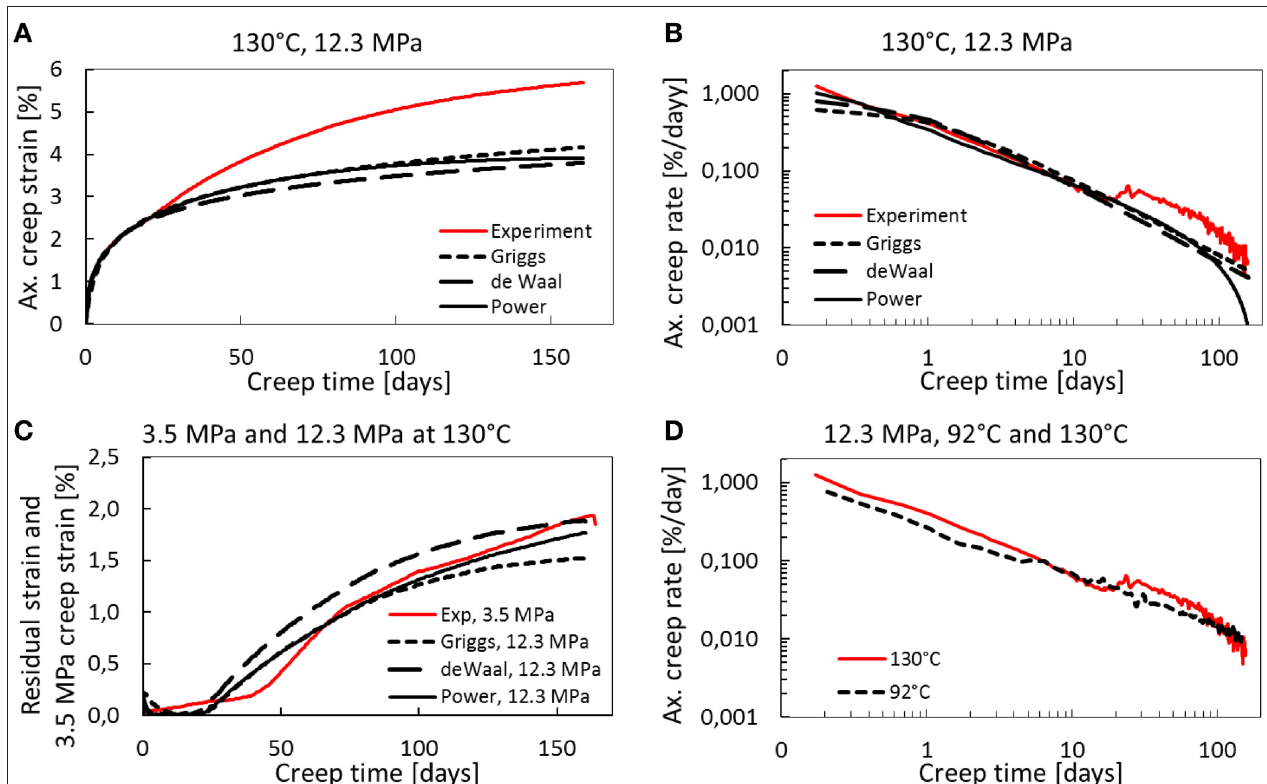
FIGURE 4 | (A) Creep curve for the 130 ◦ C and 12.3MPa effective stress experiment compared to the best model fits. The fitting has been performed on the primary creep part (i.e., first 20 days) and extrapolated to visualize the effect of chemistry. (B) Log-log plot of strain rate (in %/day) vs. time. Accelerated creep observed when the red experimental curve deviates from the models. (C) The difference between the extrapolated strain and observed strain at a given time, is plotted through time for the 12.3 and 130 ◦ C experiment (black line) and compared to the 130 ◦ C and 3.5MPa experiment creep (red stippled line). The deviation is interpreted to arise from chemical effects, which coincide with the creep dynamic of the experiment performed at 3.5MPa (below yield). (D) Comparison of the axial creep strain rate for the 92 and 130 ◦ C experiment. The GRG-nonlinear regression tool in the Solver add-in in Excel 2013 was used to search for the optimal values of A , B , and t 0 to minimize the total